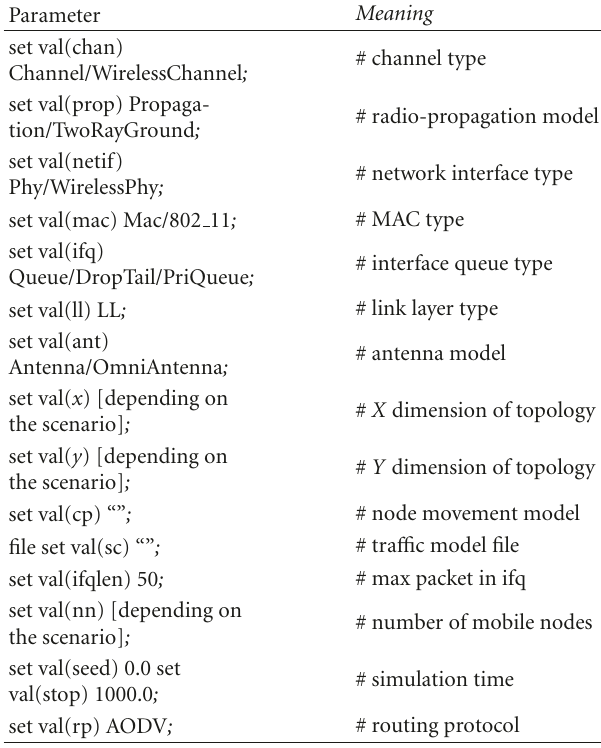
Table 2: Simulation